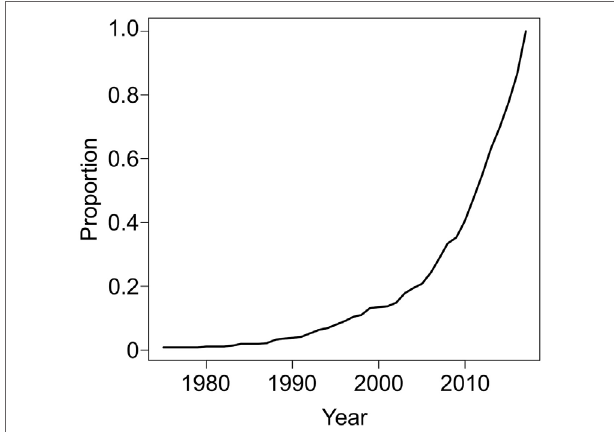
FigURe 1 | PUBMED search on January 11, 2018 (294 hits, 112 relevant) using the following terms: “stroke"[Title/Abstract] AND